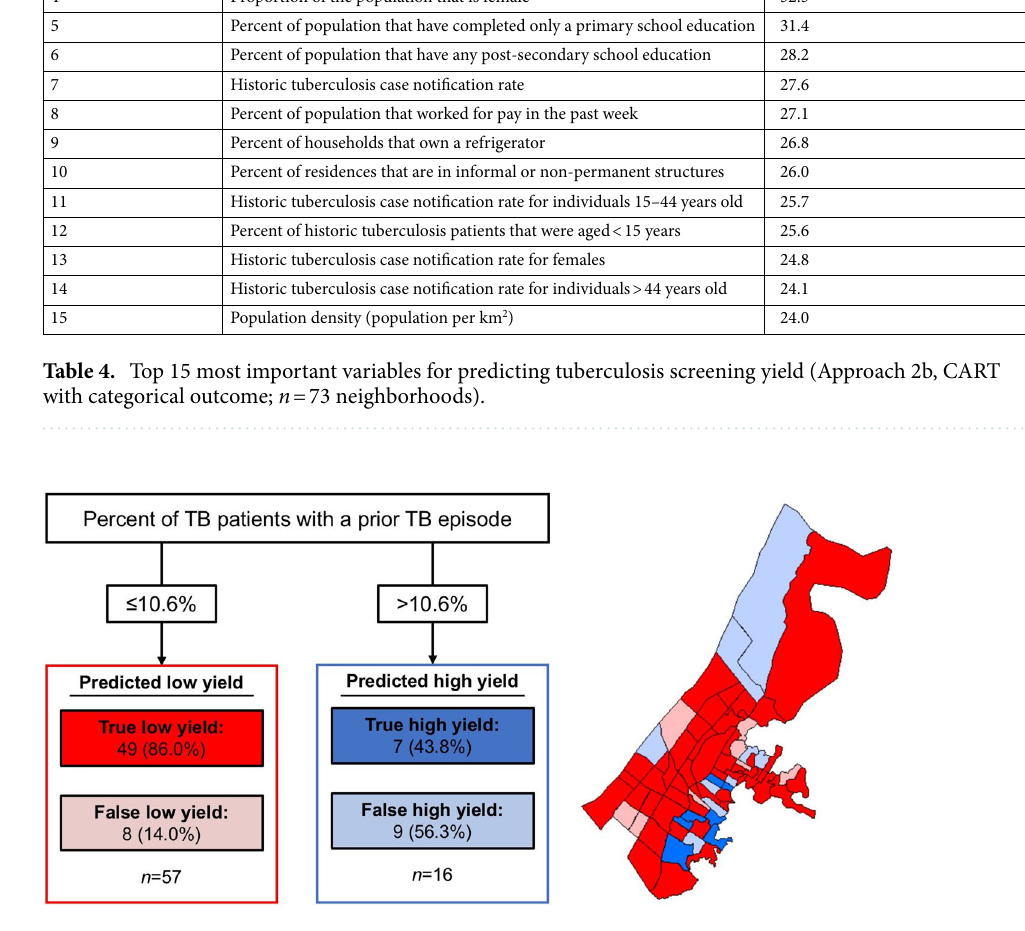
Figure 3. Distribution of tuberculosis screening yield according to neighborhood risk category (Approach 2b, n = 73 neighborhoods). Map was created by MBB using ArcMap Desktop version 10.8 (Environmental Systems Research Institute, Redlands, California, USA; https:// www. esri. com/ en- us/ arcgis/ produ cts/ arcgis- deskt